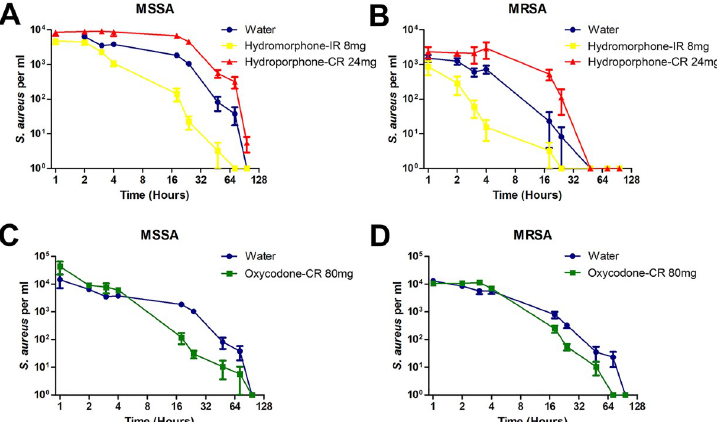
Fig 2. Persistence of S . aureus over time in immediate-release or controlled-release opioid solutions compared to sterile water control. (A-B) Clinical strains of S . aureus , both MSSA and MRSA, persisted longer in Hydromorphone- CR solution compared to both hydromorphone immediate-release (Hydromorphone-IR) solution or sterile water control. (C-D) Both MSSA and MRSA persisted longer in sterile water control when compared to oxycodone controlled-release (Oxycodone-CR)